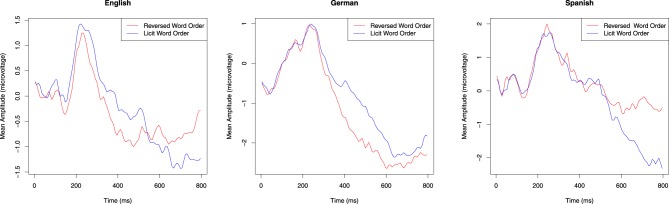
Grand average ERP for the raw data at electrode C3, by participant group and Word Order condition.